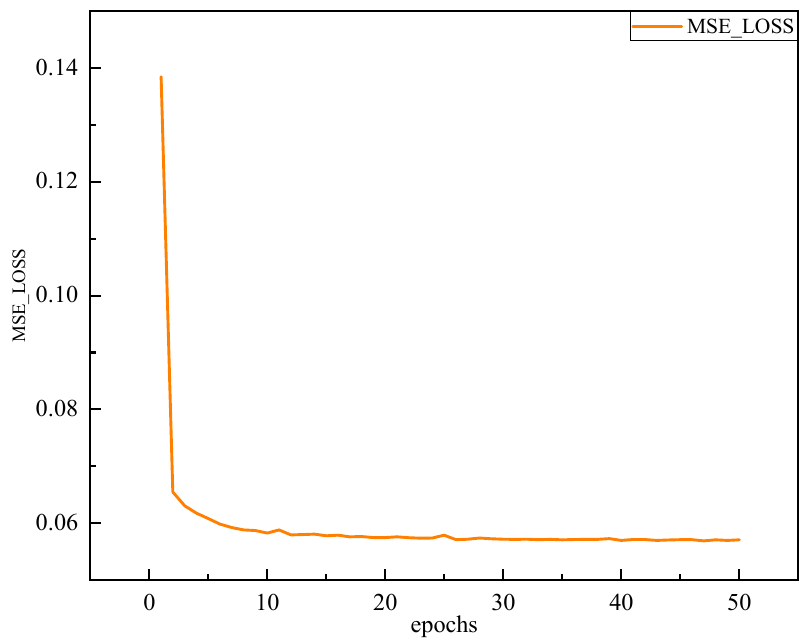
Figure 6. Curve of the MSE loss value with iteration times.